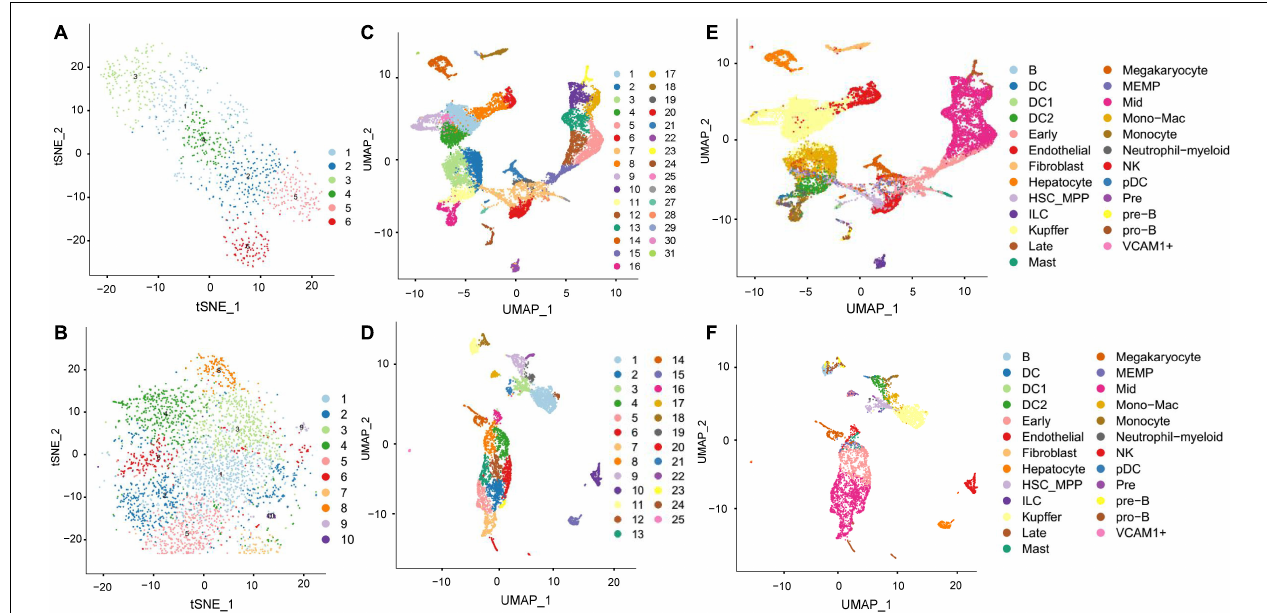
FIGURE 1 | ST and scRNA-seq identified major cell types in the human fetal livers. (A,B) The t-SNE plot of all spots from ST data of 8 PCW liver (A) and 17 PCW liver (B) . Each point represents a spot, colored by cell types. (C–F) The UMAP plot of all cells from single-cell RNA-seq of 8 PCW liver (C,E) and 17 PCW liver (D,F) . Each point represents a cell, colored by their associated cluster (C,D) , and colored by cell types (E,F)